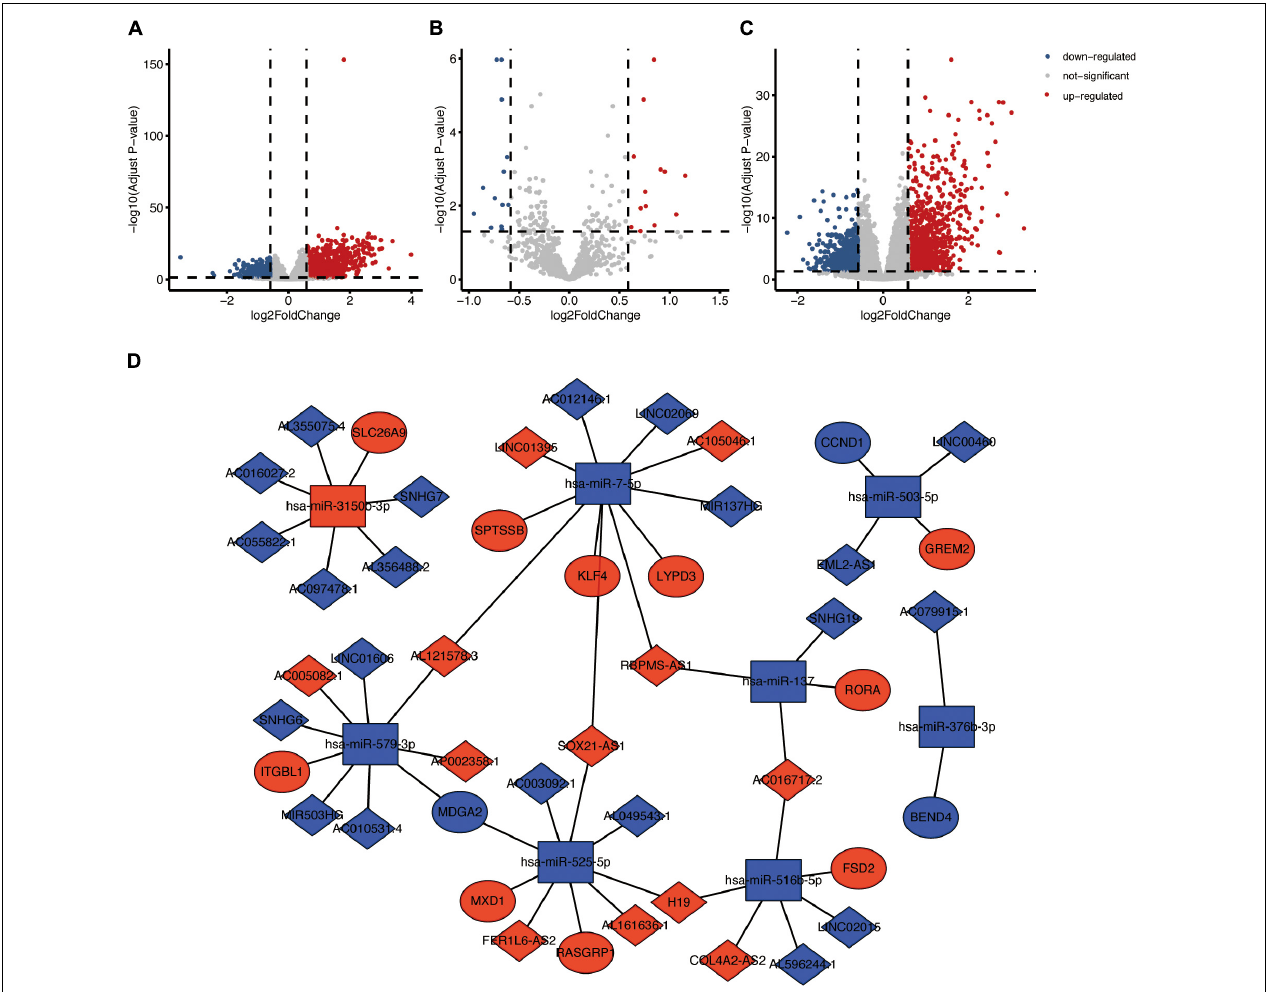
FIGURE 4 | ceRNA network based on the TP53INP2 expression in HNSCC. (A) Volcano plot of differentially expressed mRNAs between TP53INP2-high and TP53INP2-low. (B) Volcano plot of differentially expressed miRNAs between TP53INP2-high and TP53INP2-low. (C) Volcano plot of differentially expressed lncRNAs between TP53INP2-high and TP53INP2-low. (D) LncRNAs mediated ceRNA network in HNSCC based on the expression of TP53INP2. LncRNAs, mRNAs, and miRNAs are represented by diamond, ellipse, and rectangle,